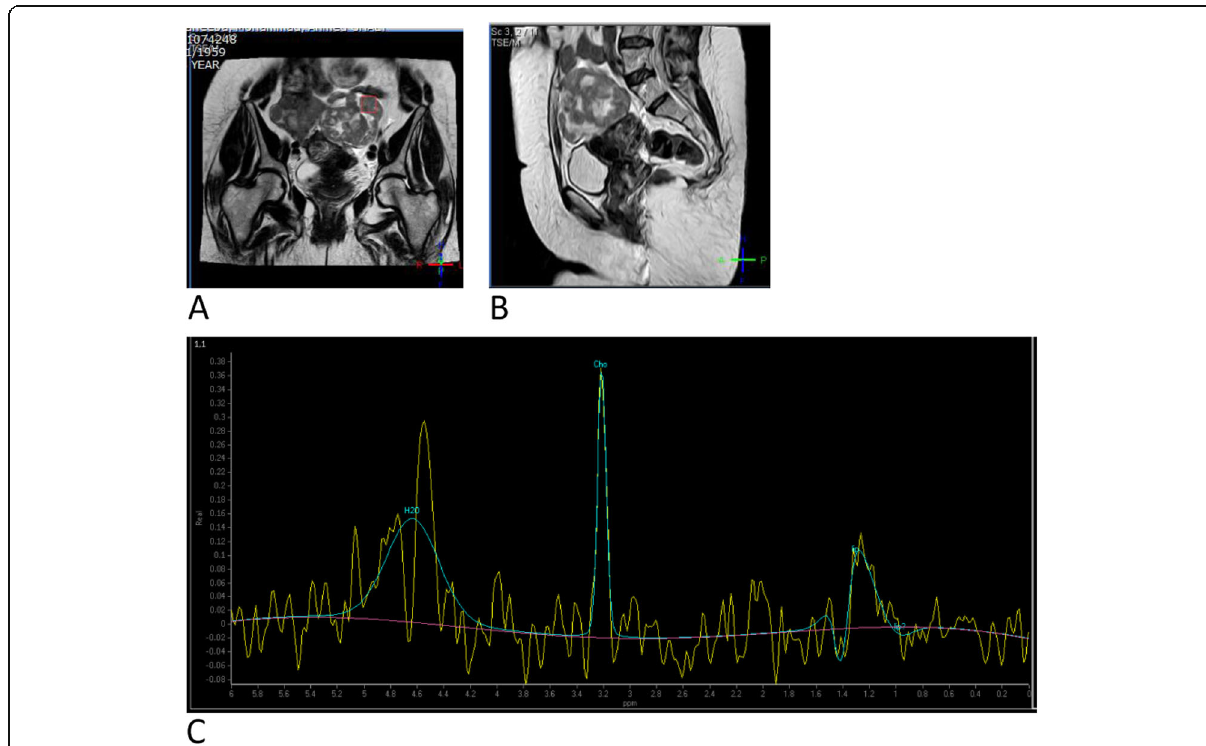
Fig. 5 A 58-year-old patient with past history of gastric and breast cancer with pathologically proven bilateral Krukenberg tumors of the ovary. a Coronal T2-weighted image showing bilateral solid ovarian masses with voxel in the center of the left one. b Sagittal T2-weighted image showing voxel in the center of mass. c MR spectroscopy shows sharp choline peak with Cho/Cr ratio 9.25 as well as lipid